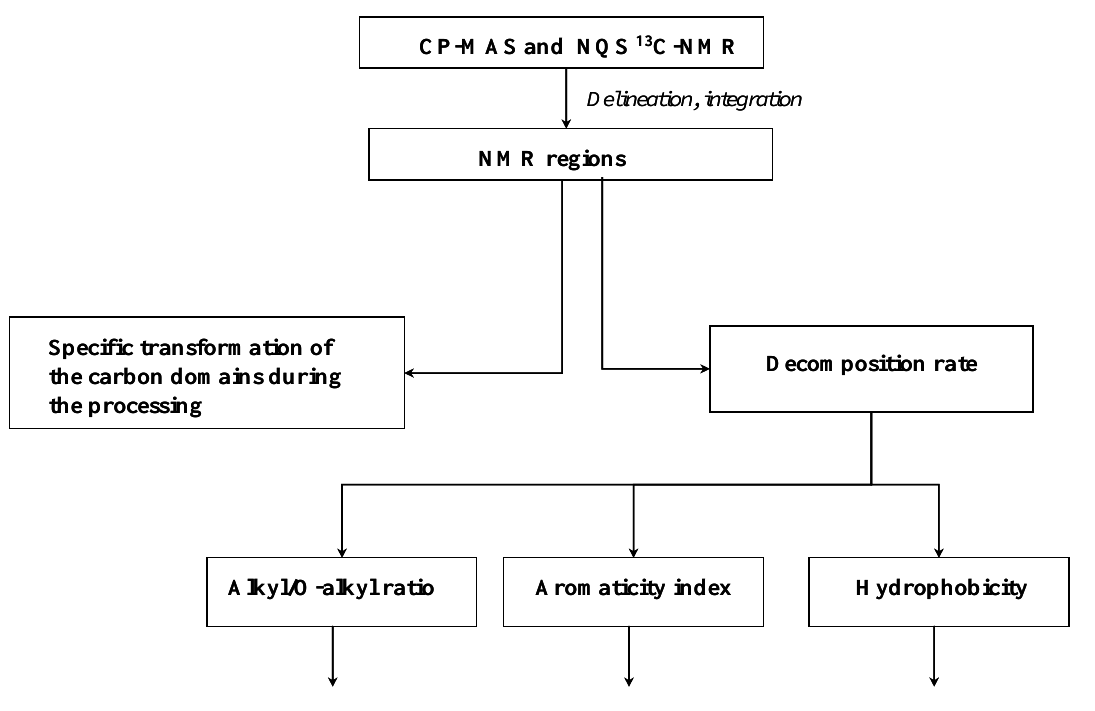
Figure 1. Schematic representation of steps for obtaining the various datasets (in boxes) discussed in the text . Obtained datasets are presented and compared in paragraphs